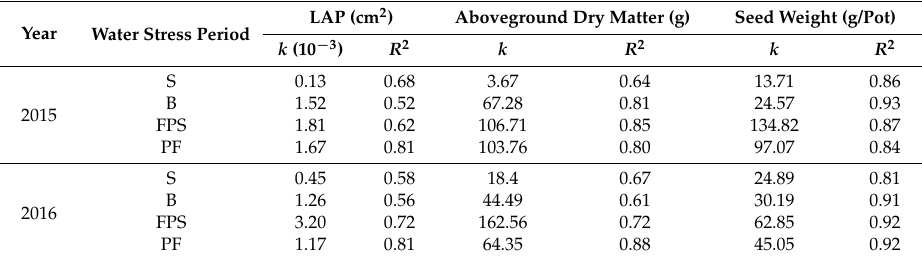
Table 5. Parameters k and coefficients of determination ( R 2 ) of the fitted